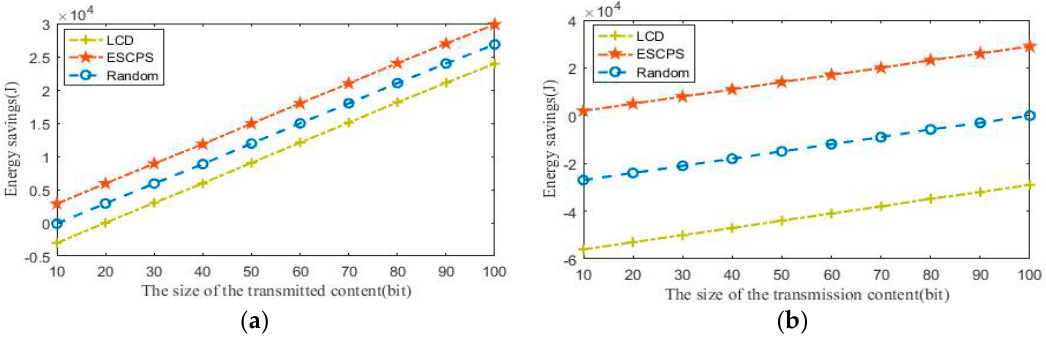
Figure 4. ( a ) The effect of distribution content size on energy savings ( P c = 0.1); ( b ) the effect of distribution content size on energy savings ( P c = 1).